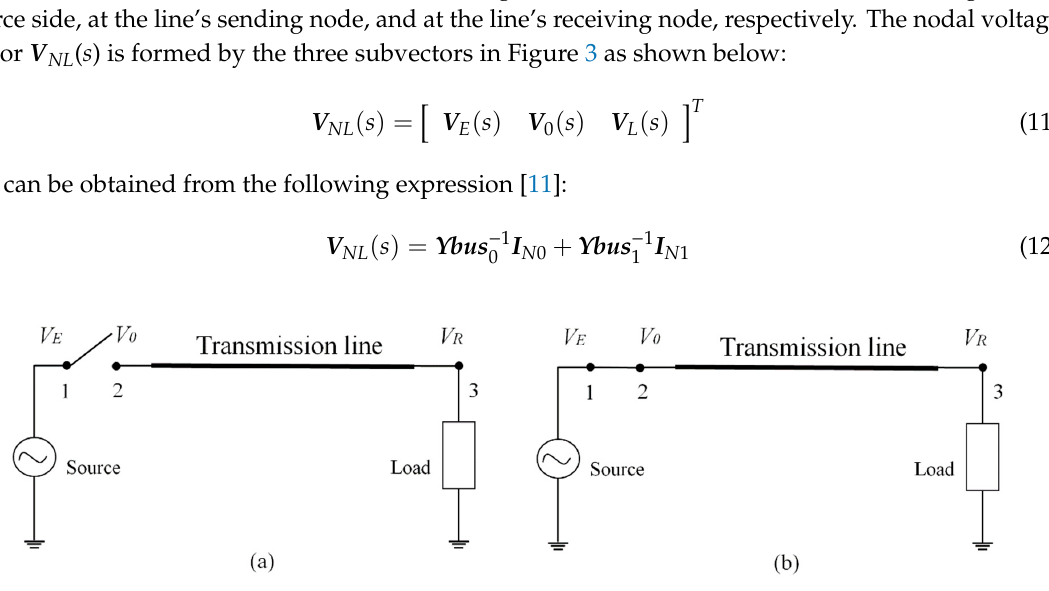
Figure 3. ( a ) Transmission line before the closing operation of a switch connected at the sending node. ( b ) Transmission line after the closing operation of a switch connected at the sending node.